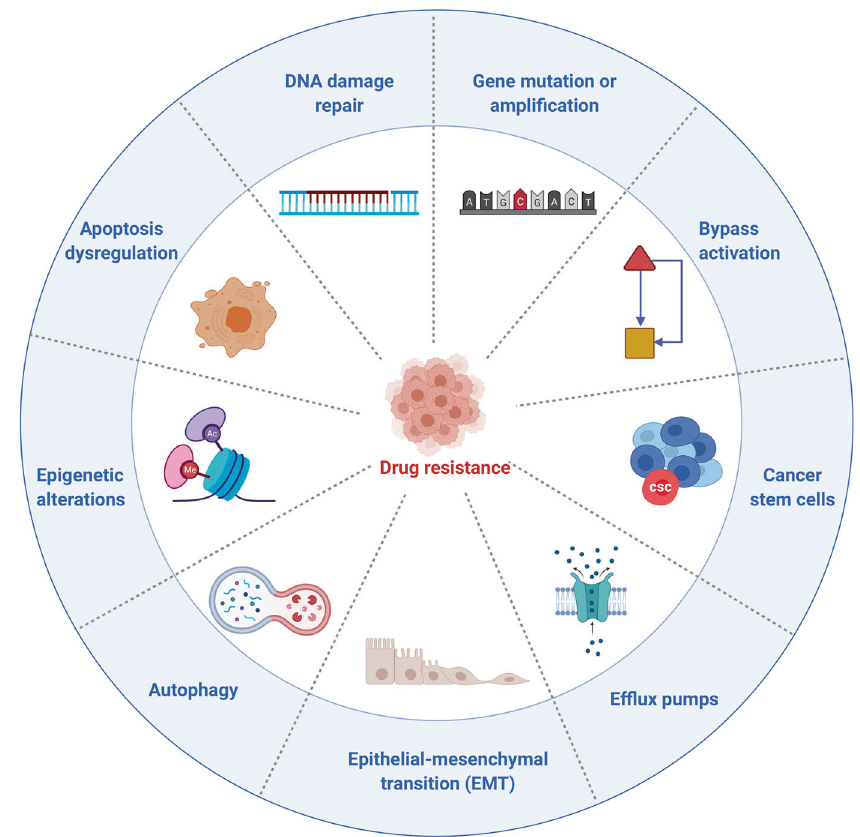
Fig. 8 Mechanisms and insights in drug resistance of small-molecule targeted anti-cancer agents. Figure created with